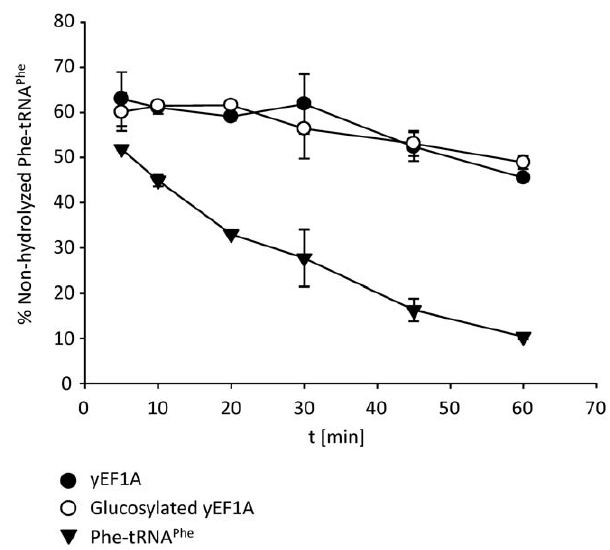
Figure 7. Effect of glucosylation on the stability of the ternary complex. Aminoacyl-tRNA stability towards hydrolysis was determined with 3 m M yeast eEF1A (yEF1A, filled circles) or glucosylated yeast eEF1A (yEF1A, open circles), 1 mM GTP and 1 m M [ 14 C]Phe-tRNA Phe for 60 min. As a control [ 14 C]Phe-tRNA Phe was incubated without eEF1A (triangles). Non-hydrolyzed [ 14 C]Phe-tRNA Phe was quantified by filter binding